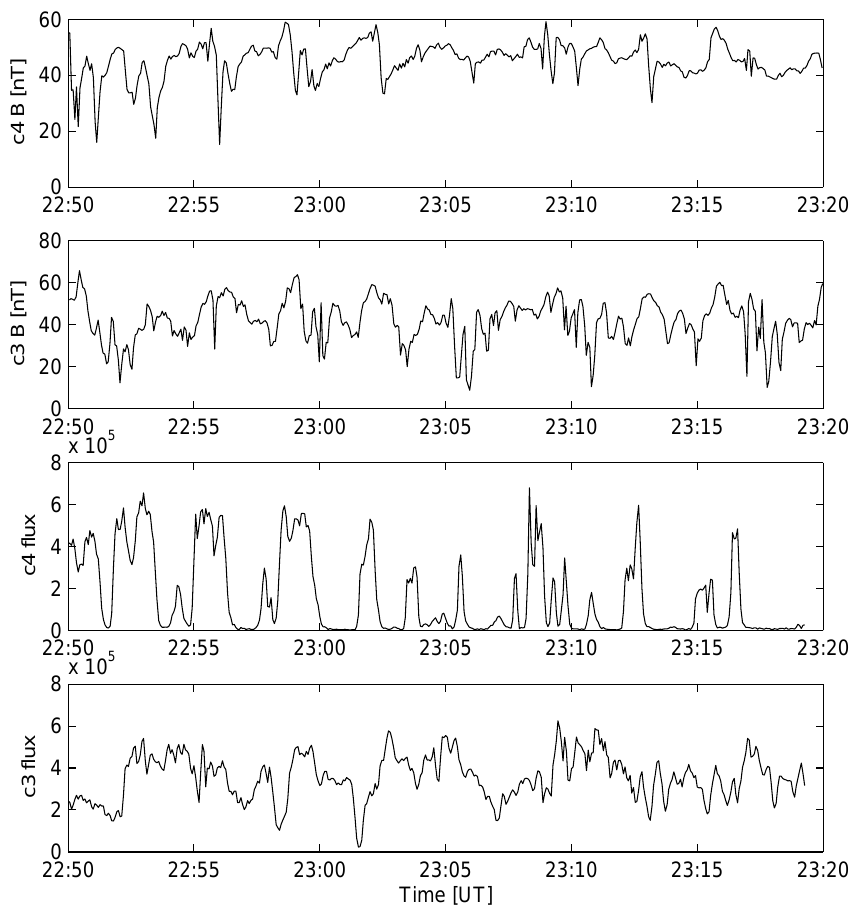
Fig. 5. The magnetic field intensities and the total proton fluxes (in units of 1/cm 2 srs) measured by the Cluster 4 (first and third panel) and Cluster 3 (second and fourth panel) satellites.